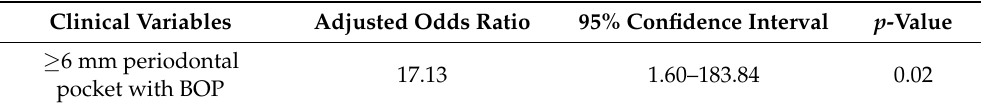
Table 4. Logistic regression analysis with C. albicans / P. gingivalis as dependent